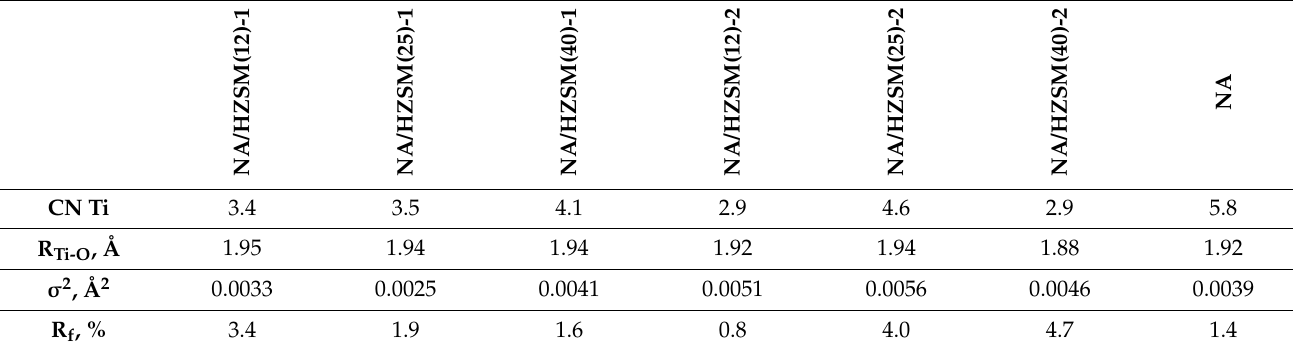
Table 6. Results of EXAFS modeling: (CN—coordination number, R Ti-O , Å—Ti-O interatomic distance, σ 2 — Debye–Waller factor, and R f —the convergence factor). Only the first coordination sphere was modeled (distance range R = 1–2 Å, range k = 2–10 Å − 1 ) (data from